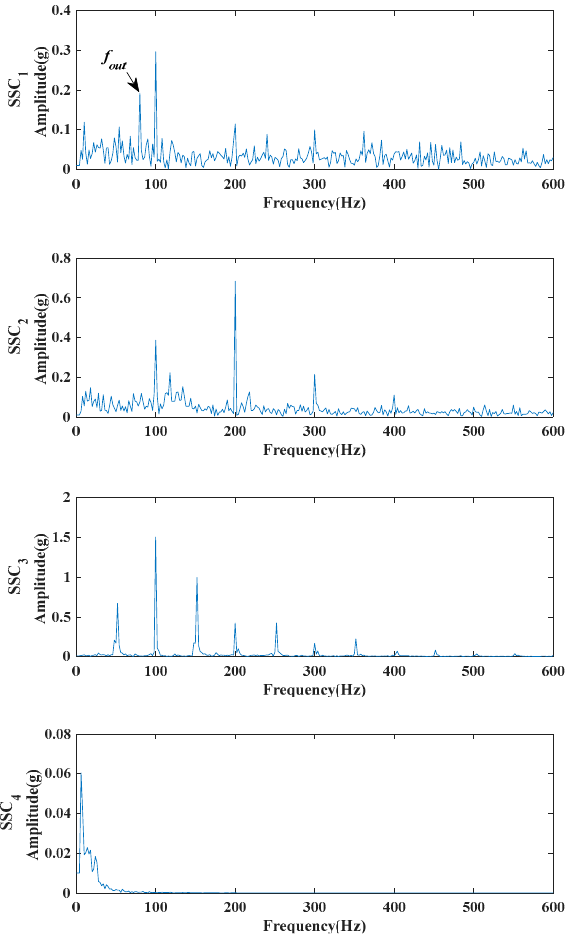
Figure 26. SSD decomposing results of the engineering fault signal.